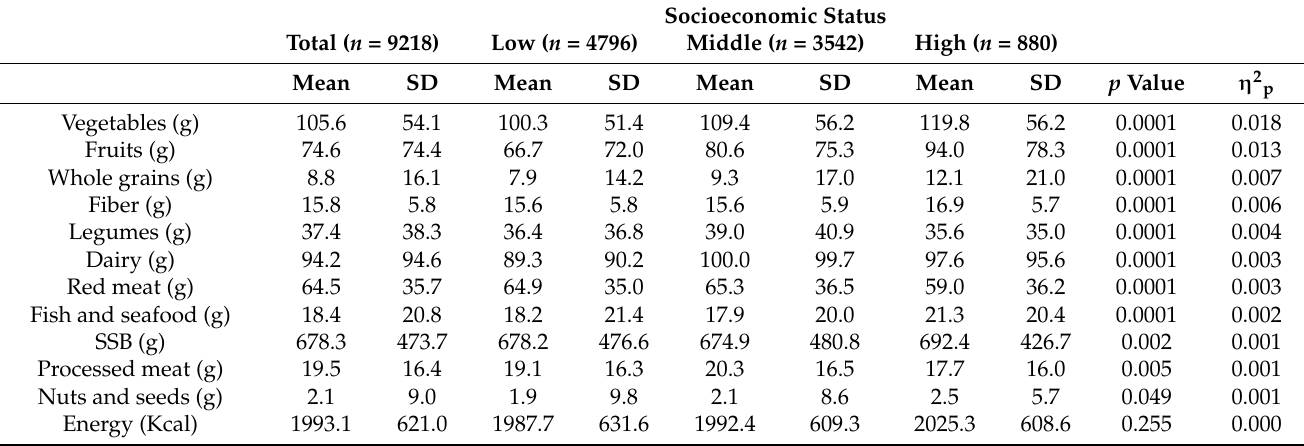
Table 2. Consumption of food groups among the socioeconomic status—the Latin American Health and Nutrition Study